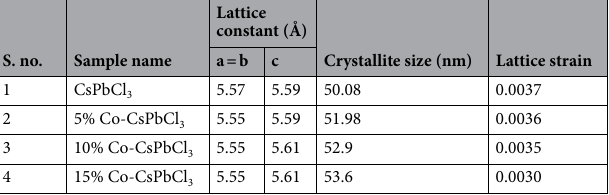
Table1. Represents the lattice parameter, crystallite size, strain of Pristine and Co doped CsPbCl 3 nanostructures.